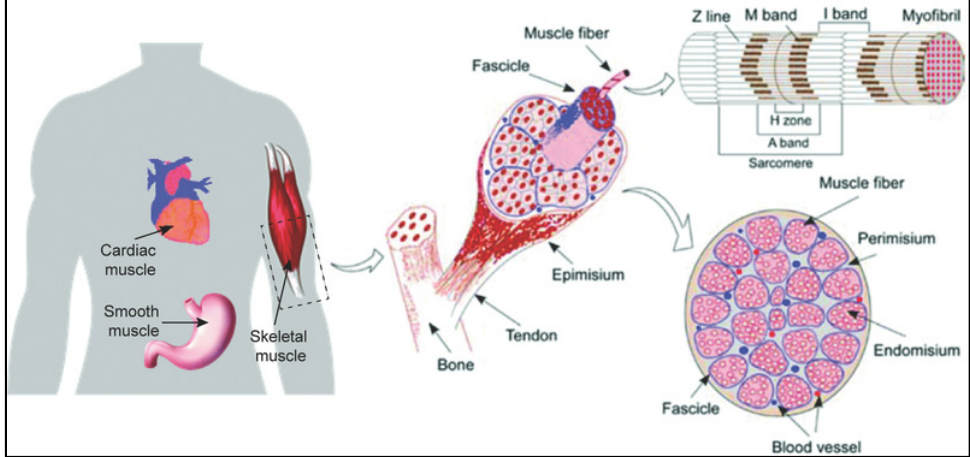
Figure 1. Schematic illustration of anatomic structures and organization of skeletal muscle tissue [17]. Copyright © 2016 by John Wiley and Sons. Reprinted by permission of John Wiley and Sons.